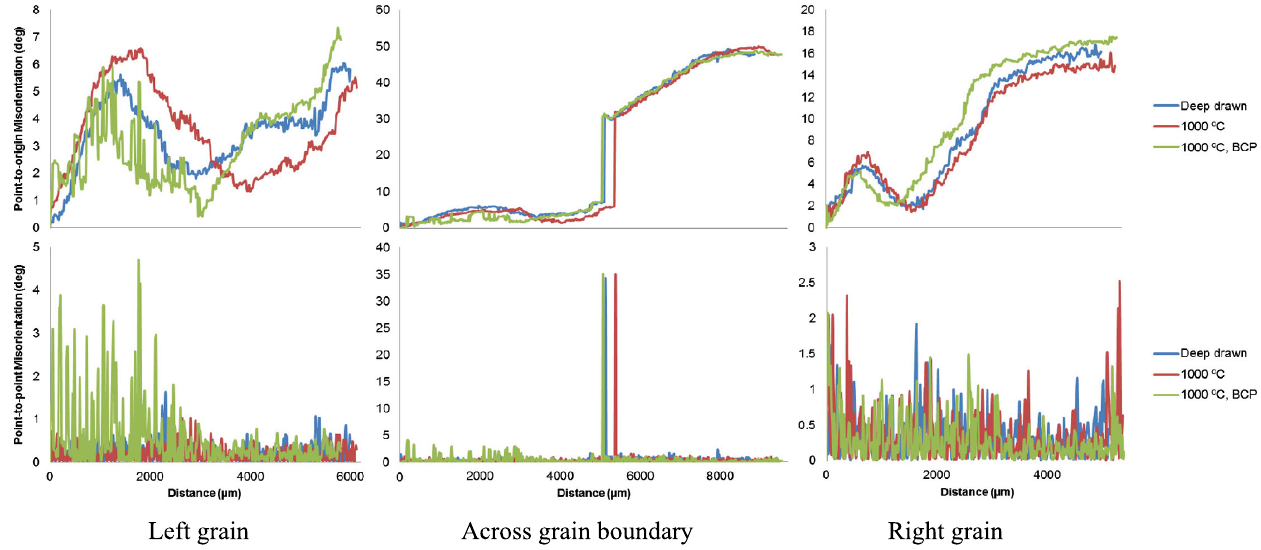
FIG. 7. Point-to-origin (upper 3) and point-to-point (lower 3) misorientation profiles for the three colored lines drawn on Equator 2 in Fig. 5. The blue ends of the colored lines in Fig. 5 are at the origin.